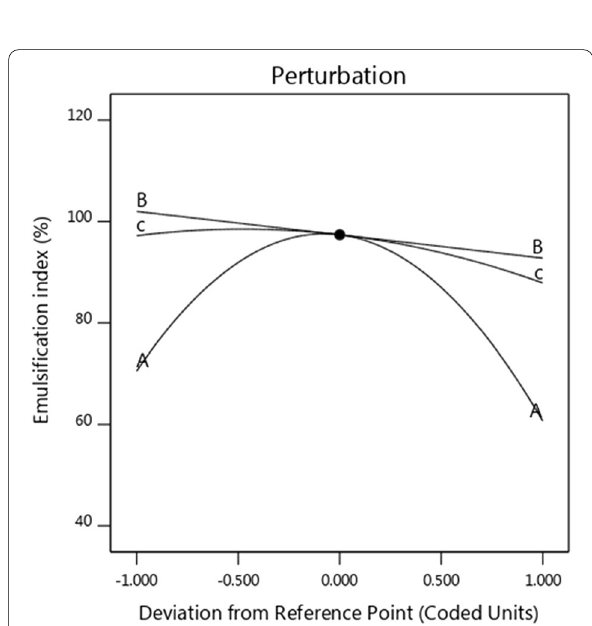
Fig. 7 Impact of factors, A: pH, B: Incubation time, C: Agitation